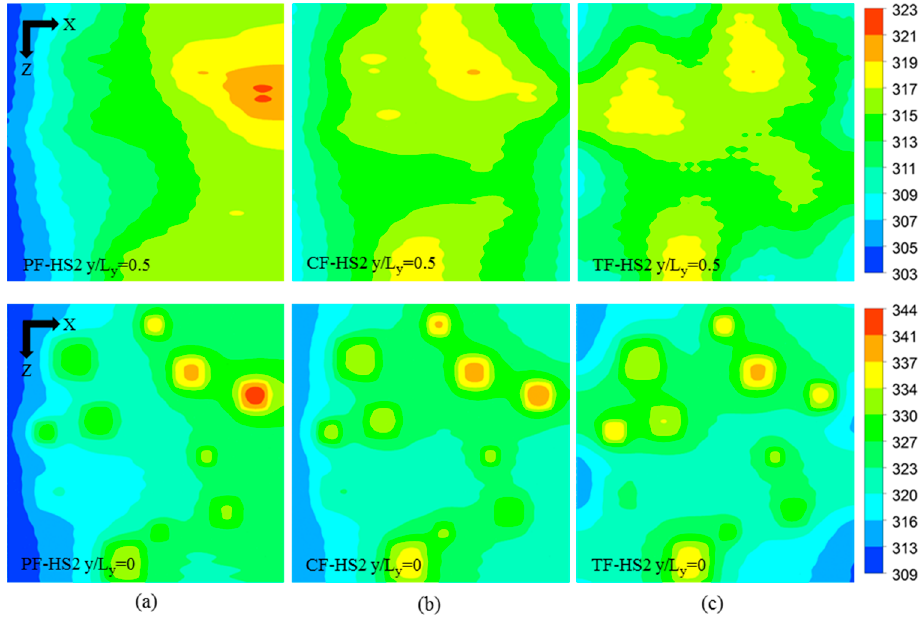
Figure 9. Temperature contours at the base ( y / L y = 0) and at the middle height ( y / L y = 0.5) of the heat sinks with the hotspot scheme HS2 at the total flow rate of 0.01 kg/s: ( a ) PF-HS2; ( b ) CF-HS2; and ( c ) TF-HS2.